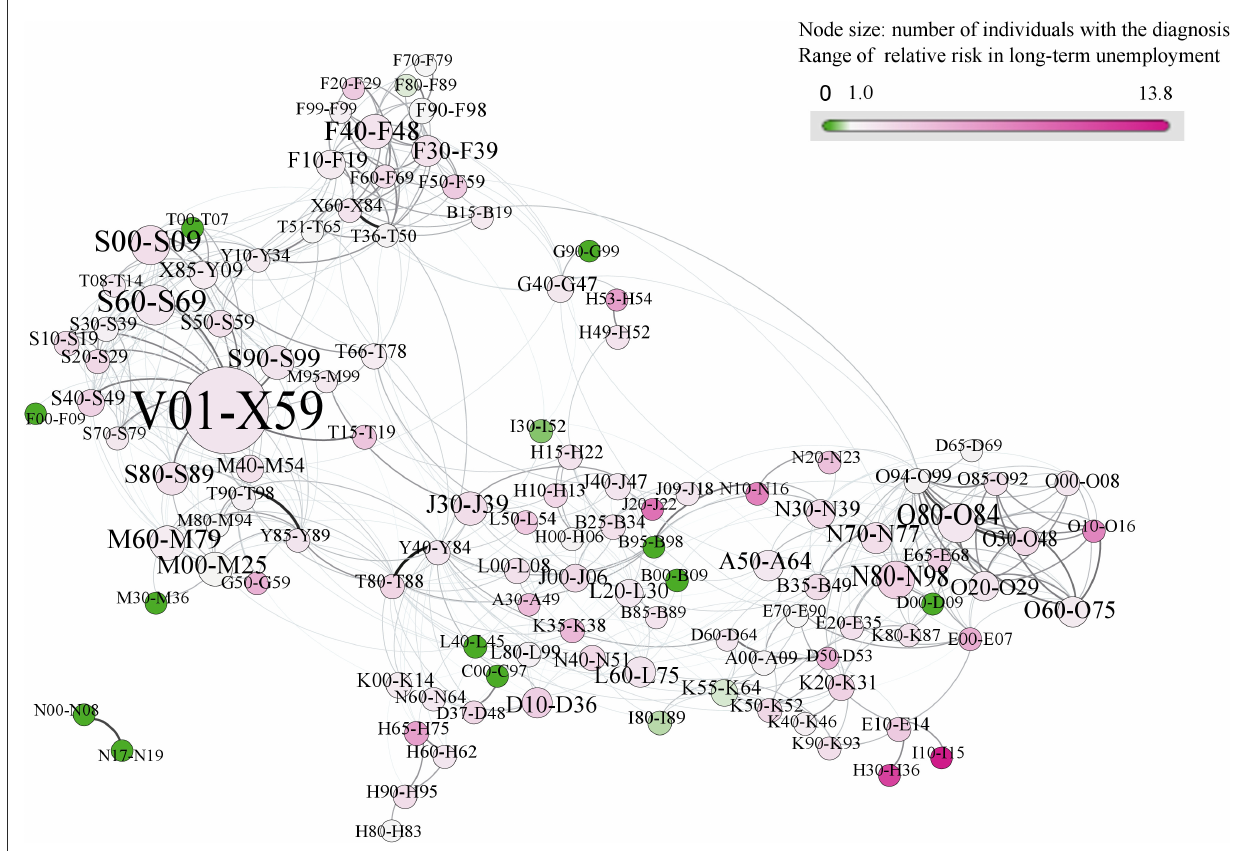
FIGURE1 Multimorbidity network showing diagnose-specific relative risks for long-term unemployment in refugees vs. Swedish-born youths with common mental disorders (CMDs) ( n = 249,245). In this multimorbidity network, each node (circle) encodes an ICD-10 diagnostic group, with a size given by the number of individuals with diagnoses in that diagnostic group, and colors giving the relative risk (RRs) for unemployment of refugee vs. the Swedish-born with common mental disorders (CMDs), respectively. Links between diagnostic groups indicate the tendency of co-occurrence in the same individual. The colors range from green to purple, corresponding to RRs from low to high. A node colored in green (purple) suggests that refugees with CMDs in that diagnostic group have a lower (higher) risk for long-term unemployment, compared to the Swedish-born counterparts. Overall, refugees with CMDs showed a higher risk for unemployment in the majority of diagnostic